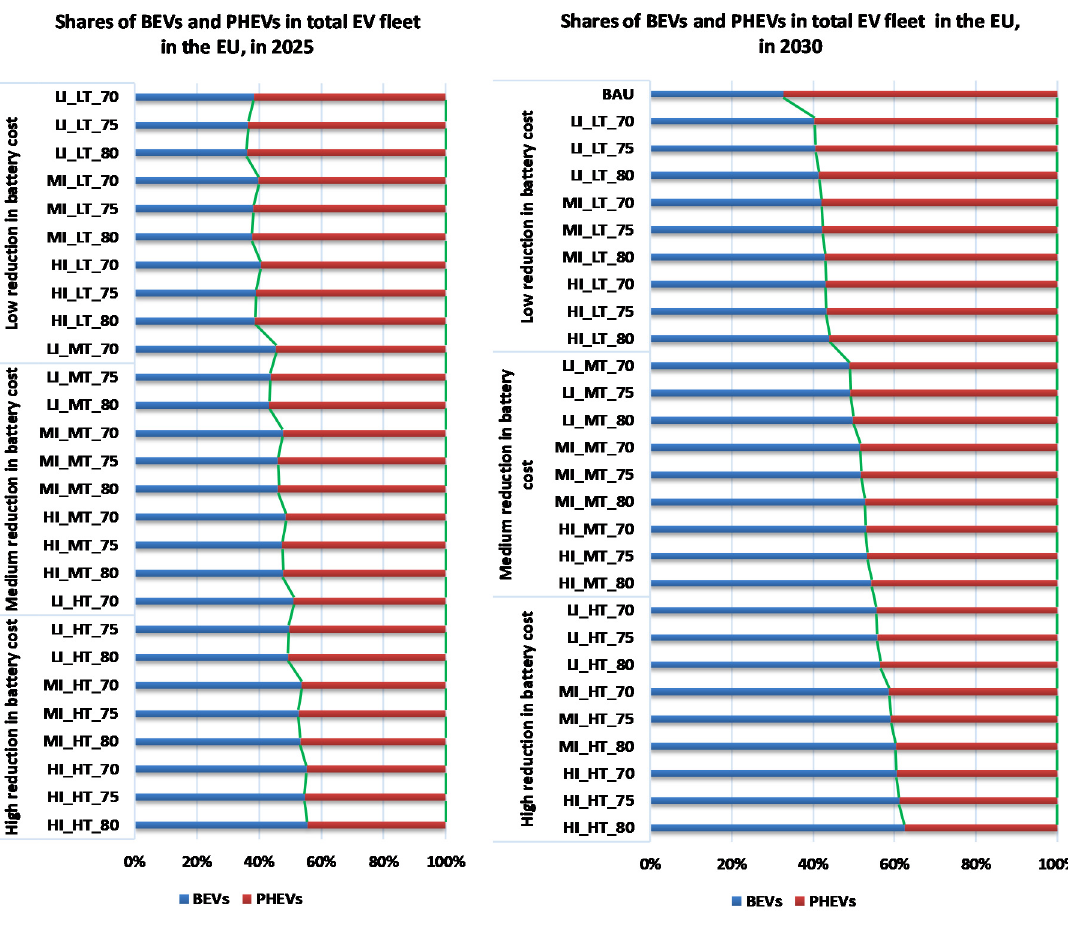
Figure 4. Market shares of BEVs and PHEVs in the total fleet of electric cars.